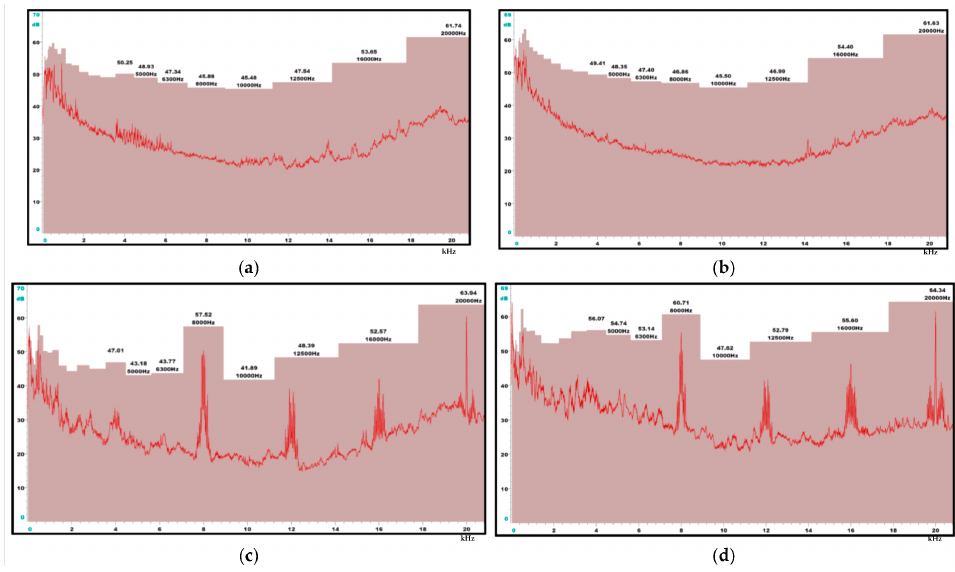
Figure 6. One third octave band spectrum: ( a ) R-134A without control system, ( b ) R-449A without control system, ( c ) R-134A with control system, and ( d ) R-449A with control